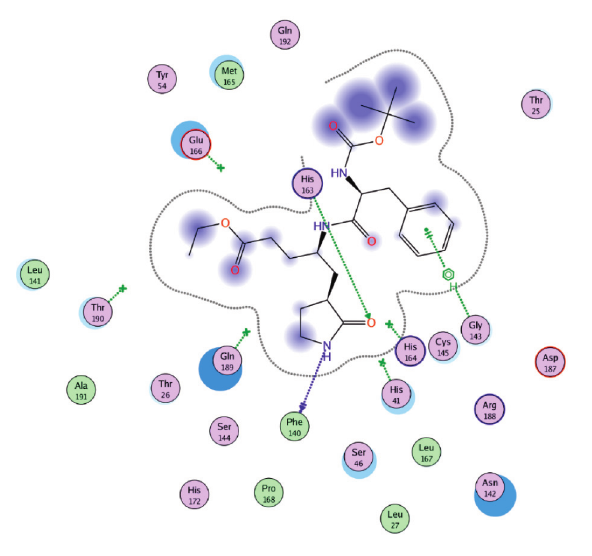
Figure 4: 2D interaction of the cocrystallized ligand (PRD-002214) in the active site of the COVID-19 main protease.